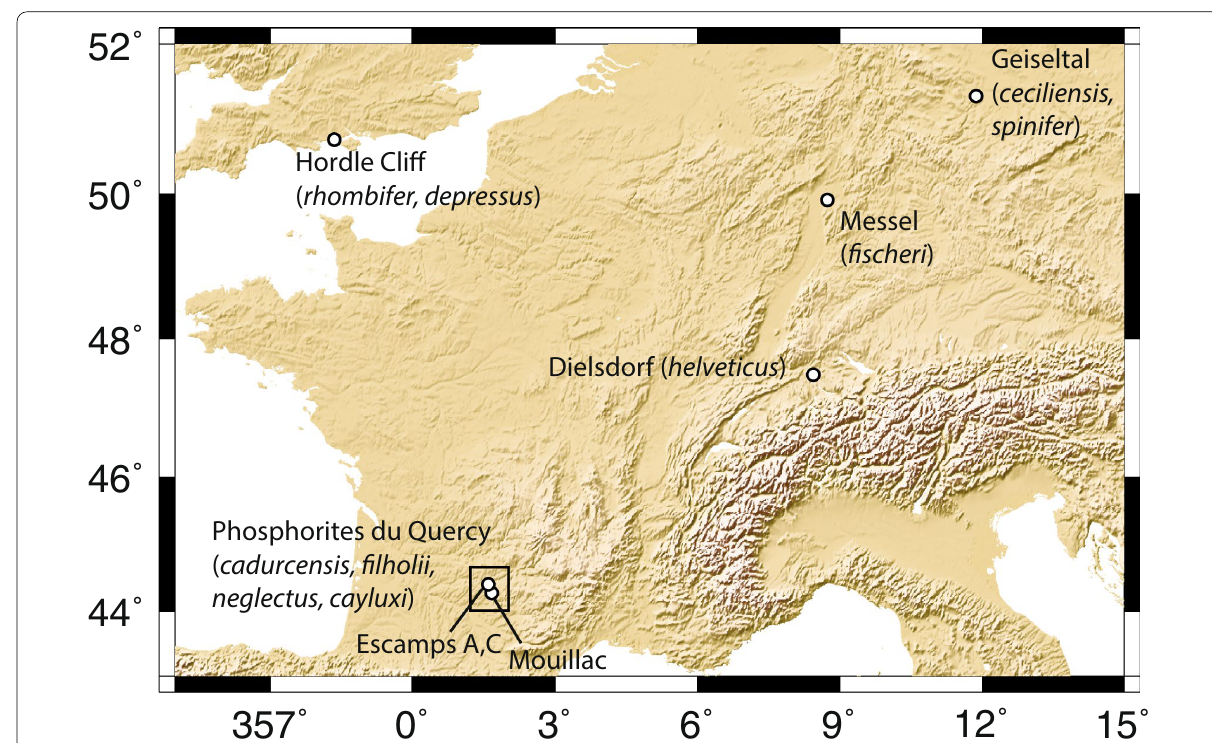
Fig. 2 Map of Western and Central Europe, indicating the localities which yielded specimens described in this paper. Base map created using Generic Mapping Tools (Wessel et al.